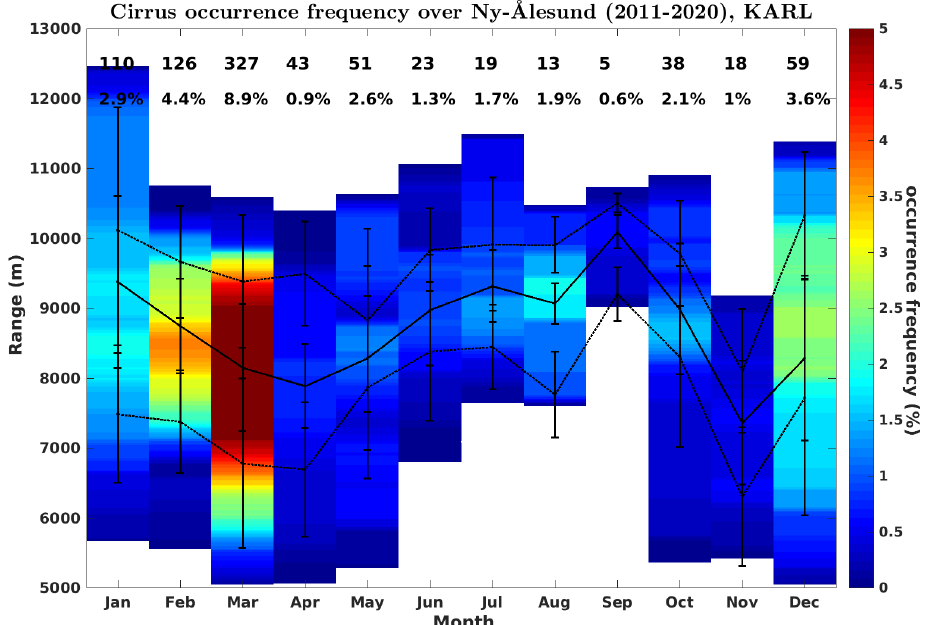
Figure 2. Cirrus monthly occurrence frequency (9 min–7.5 m) cirrus observations normalized to KARL observation hours). The numbers on top denote the detected cirrus layers and the cirrus occurrence frequency. The C base , effective C mid and C top are overlaid (median and standard deviation).